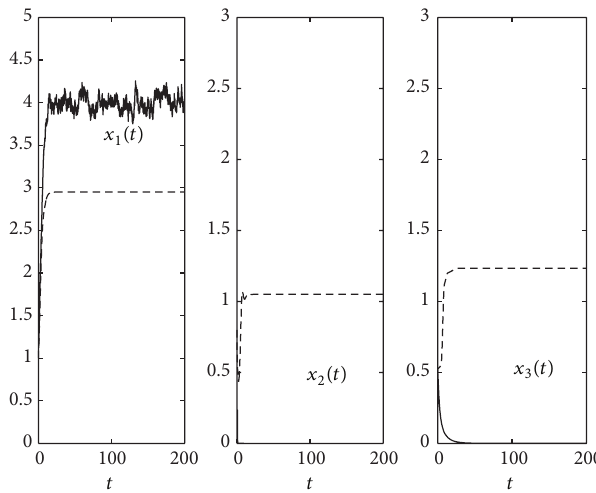
Figure 2: Two of the species will die out in probability. The red lines represent the solution of system (1), while the blue lines represent the solution of system (3) with (𝑥 1 (0),𝑥 2 (0),𝑥 3 (0)) = (1,0.8, 0.5) , = 0.4 , 𝑎 = 0.4 , 𝑎 = 0.1 , 𝑏 = 0.1 , 𝑏 = 0.1 , 𝑏 = 0.6 , 𝑏 = 0.6 , 𝑎 1 2 3 11 12 21 22 = 0.6 , 𝑏 = 0.8 ,and 𝑏 = 0.6 .Theredlinesrepresentthesolution 𝑏 23 32 33 of system (1), while the blue lines represent the solution of system (3) with 𝜎 1 = 0.02 , 𝜎 2 = 3 , and 𝜎 3 = 0.01 .